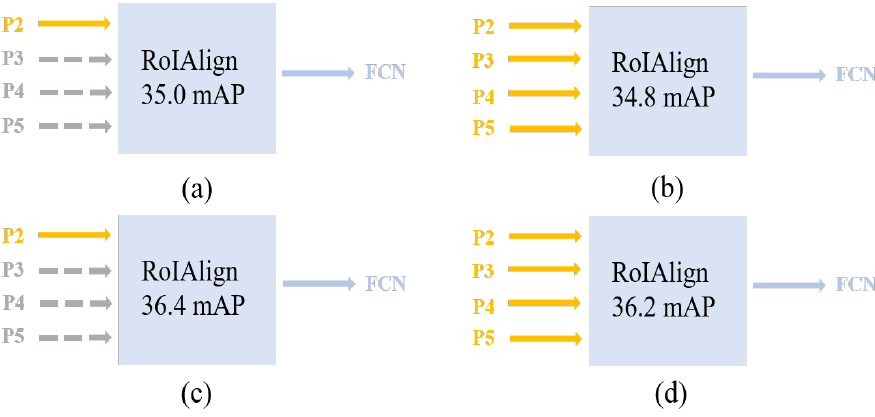
Figure 1. Comparison of mAP for different feature layers. P2, P3, P4 and P5 denote the output features of FPN [11]. Its output features are extracted by RoIAlign [9] and passed into the FCN [9]. ( a , c ) Extraction of the P2 feature layer of the FPN as the input features of the FCN. ( b , d ) Extraction of all its feature layers as input features to the mask head. ( a , b ) Resnet50 is used [12]. ( c , d ) Resnet101 is used [12]. On COCO2017 validation using a 1 training strategy, the above experiments were